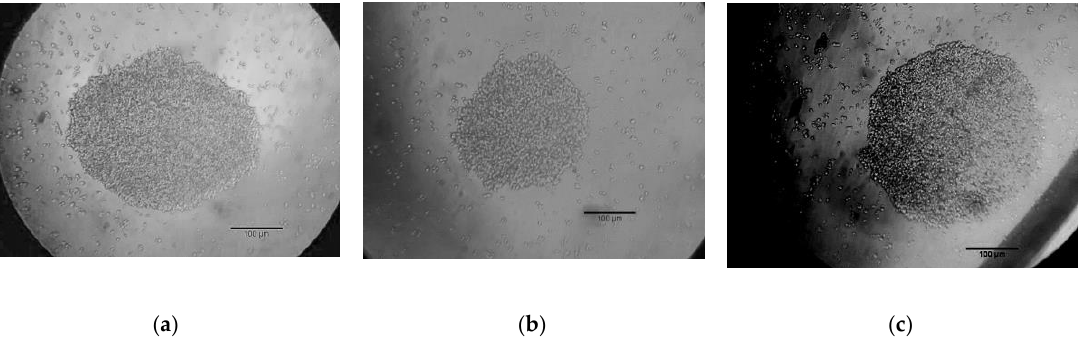
Figure 8. 3D tumor spheroid images at Day 3 under treatments of TbPO 4 ·H 2 O@silica-NH 2 ( a ), TMC ( b ), and negative control ( c ) using an Olympus Scan^R 100X fluorescence microscope system for observation.